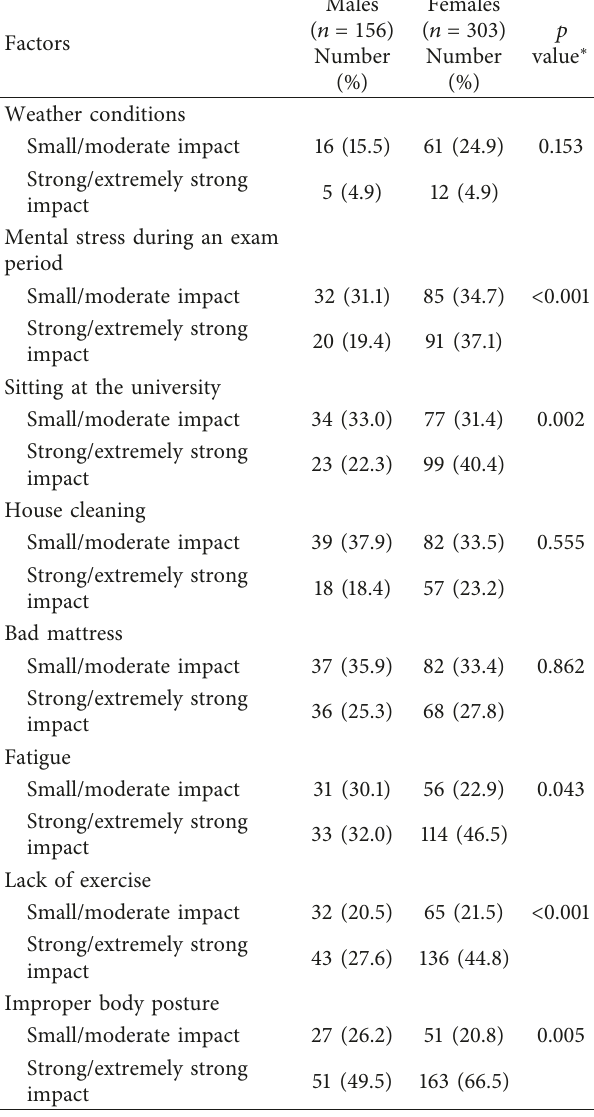
Table 2: Self-perceived subjective triggers connected with occur- rence of low back pain among medical students regarding their